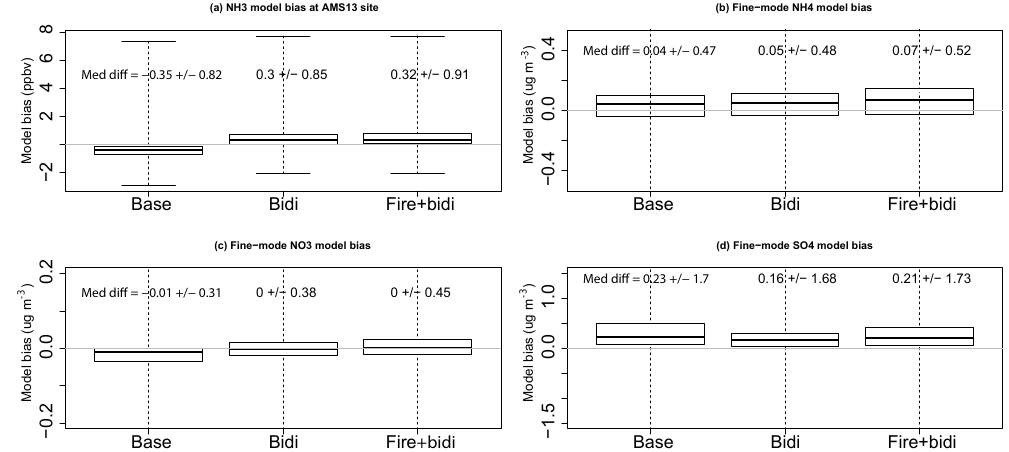
Figure 5. Hourly model–measurement bias in surface (a) NH 3 VMR, and (b) NH + ground site in the AOSR.